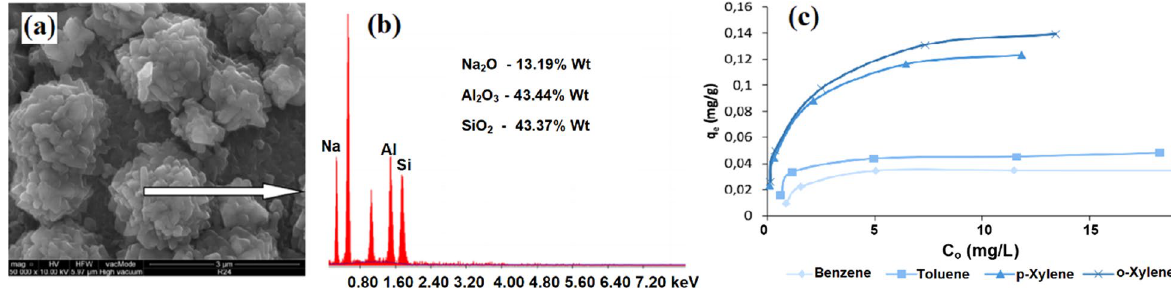
Fig. 32 Na-P1 Zeolite a SEM image, b EDX image and c Adsorption capacity for BTX (Bandura et al. 2017)